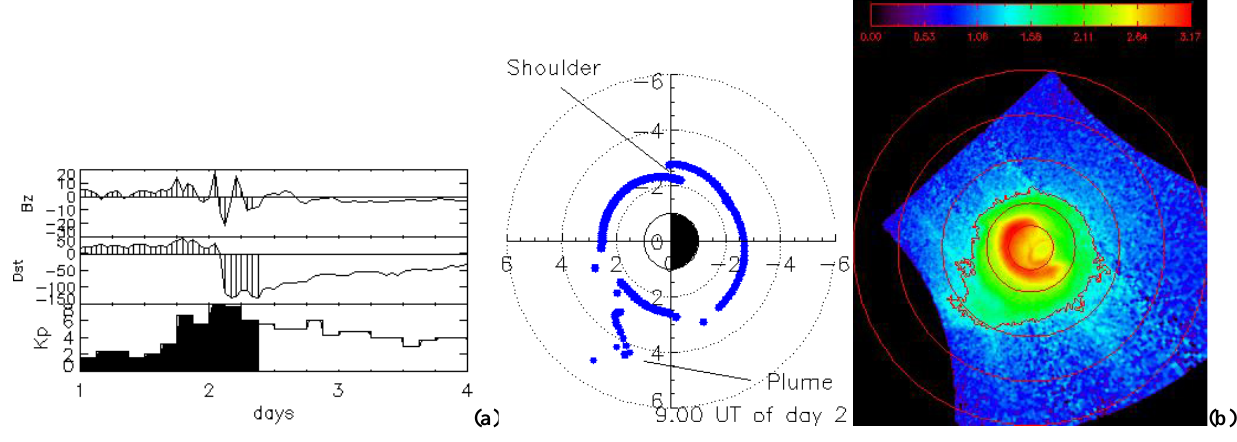
Fig. 11. Same as Fig. 1 for 24 May 2000, 09:00 ( (a) , simulation) and 09:02 UT ( (b) , EUV observation). A plume develops in the afternoon